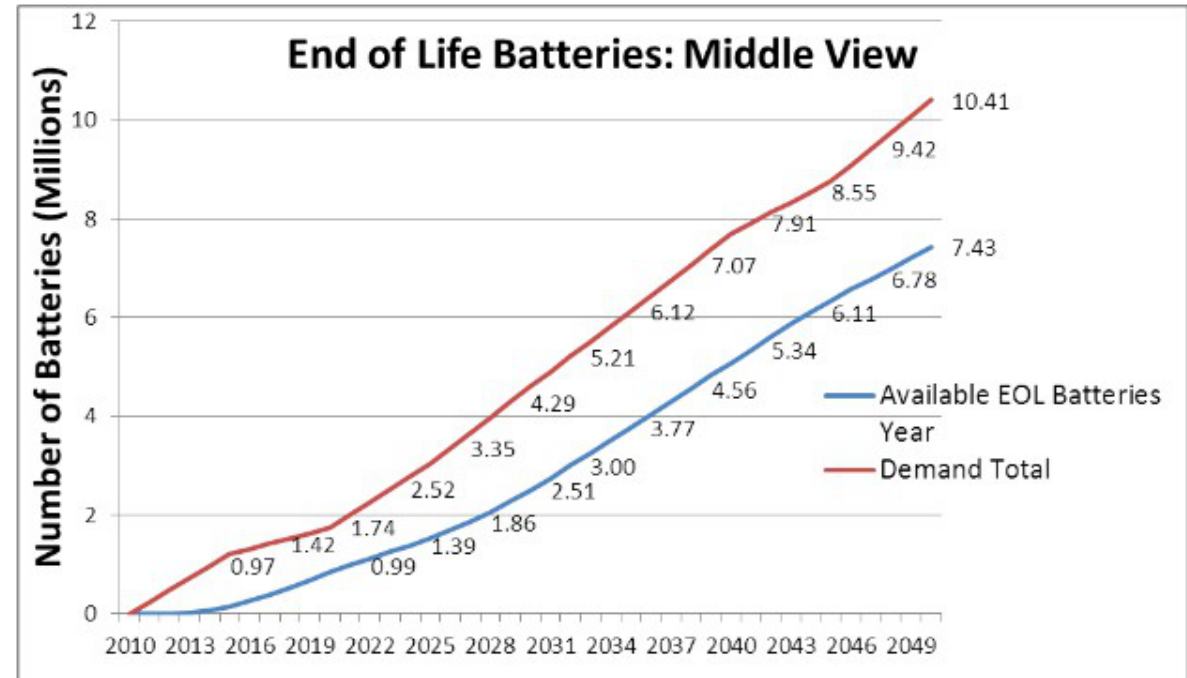
Figure 3. Middle View of the Number of Available End of Life Batteries based on Industrial Forecasts